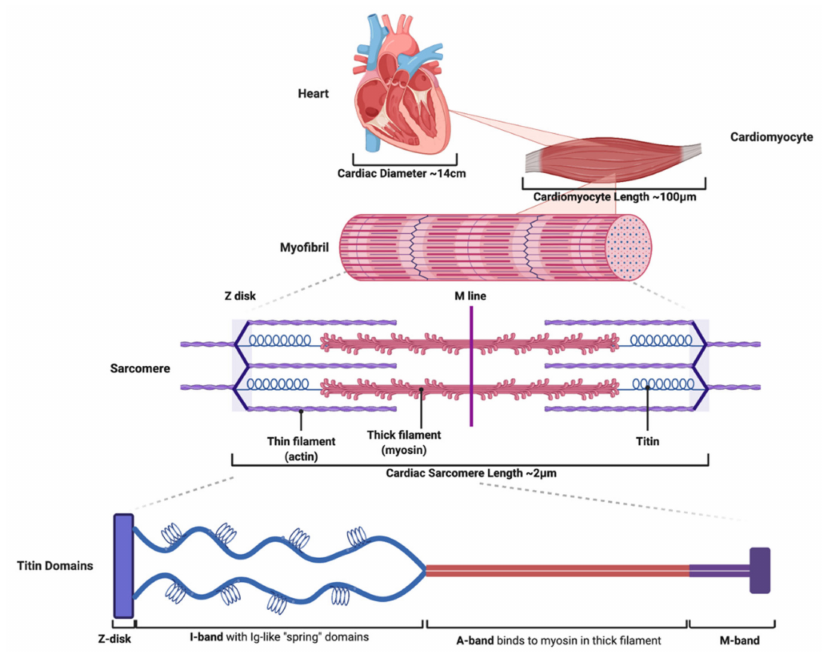
Figure 1. Titin structural domains serve essential functional roles as part of the sarcomere, myofibril, and cardiomyocyte. Cardiac tissue is composed of cardiomyocytes that impart contractile function. The contractile subunit of the cardiomyocyte is the myofibril, which is made of sarcomeres. Titin is an essential component of the sarcomere composed of four domains. The N-terminal domain embeds titin to the Z-disk. The I-band contains immunoglobulin-like (Ig) domains that impart extensibility and provide titin “spring-like” characteristics. The A-band binds to myosin and serves as a rigid region during contraction. The C-terminal domains embeds titin to the